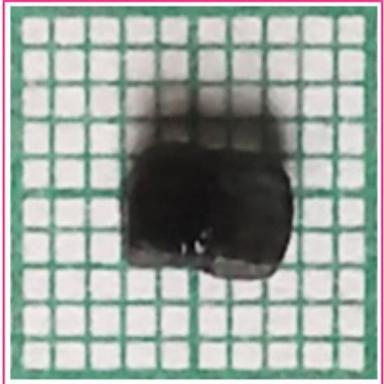
ptical images of as-grown HAPH crystals